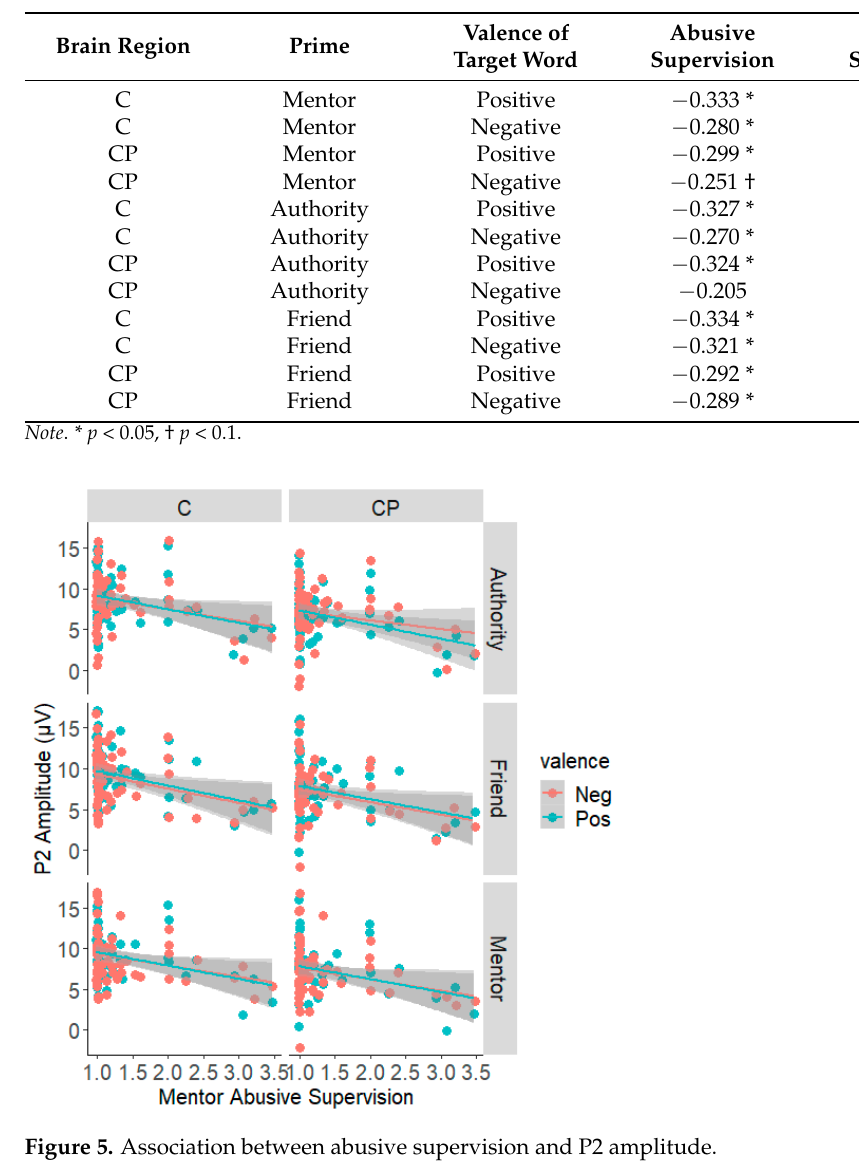
Table 1. Association between P2 and students’ evaluation of mentorship.